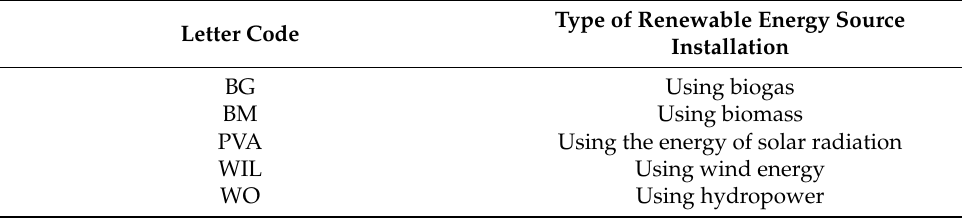
Table 7. Letter codes for types of renewable energy